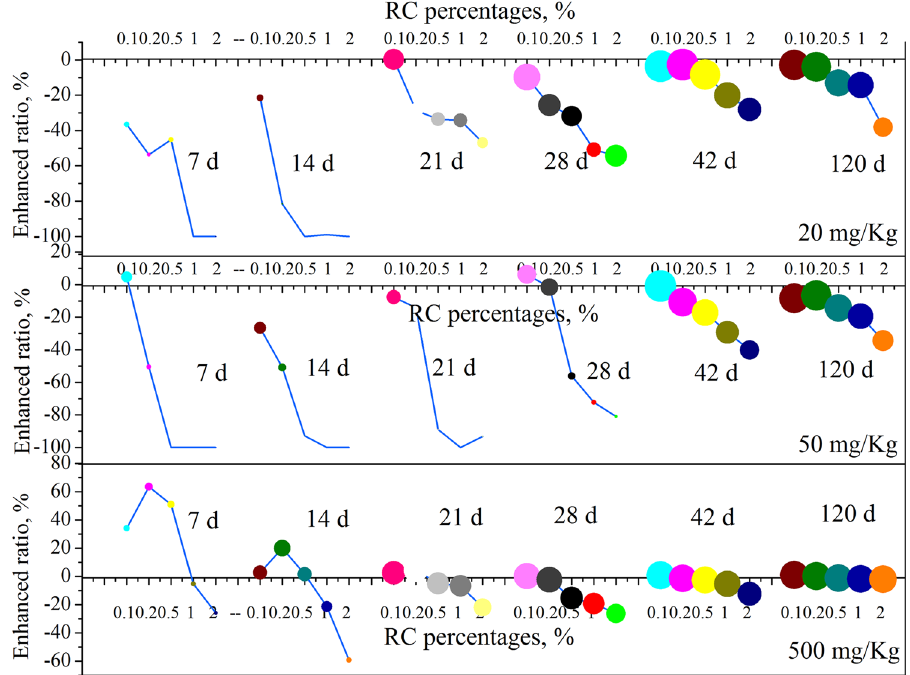
Figure 2. Impact of RC percentages on biodegradation of NP with different concentration in sediment. Enhancement ratio of RC on NP biodegradation was calculated by NP removal efficiency using pure sediment samples as blank control. 0.1, 0.2, 0.5, 1.0 and 2.0 in horizontal axis represent 0.1, 0.2, 0.5, 1.0 and 2.0% RC percentages in sediment, respectively. The size of color circles represents NP removal